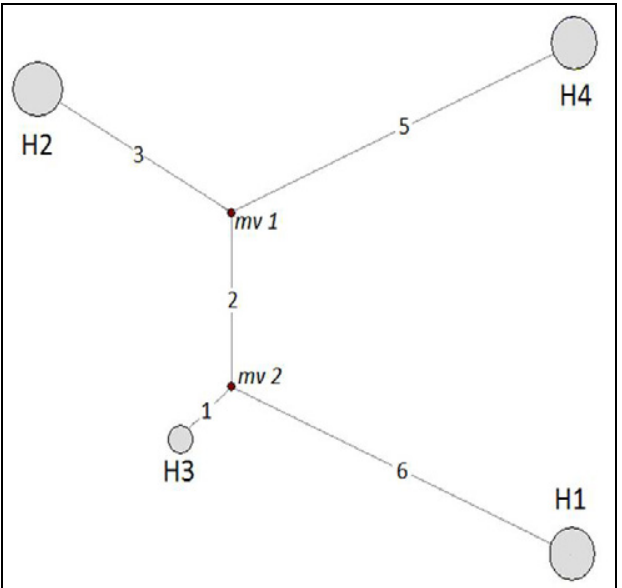
- Cox 2 region from leu